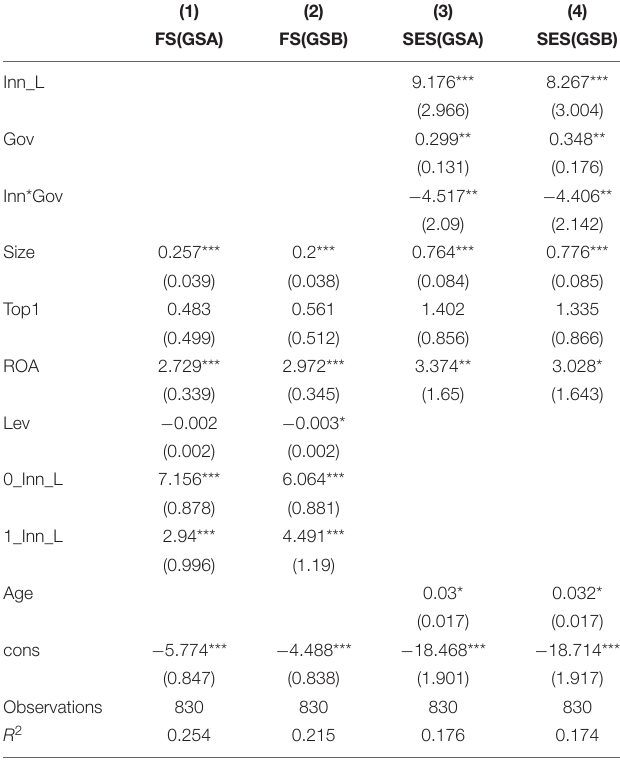
TABLE 9 | Effects of GSA and GSB on corporate sustainability.